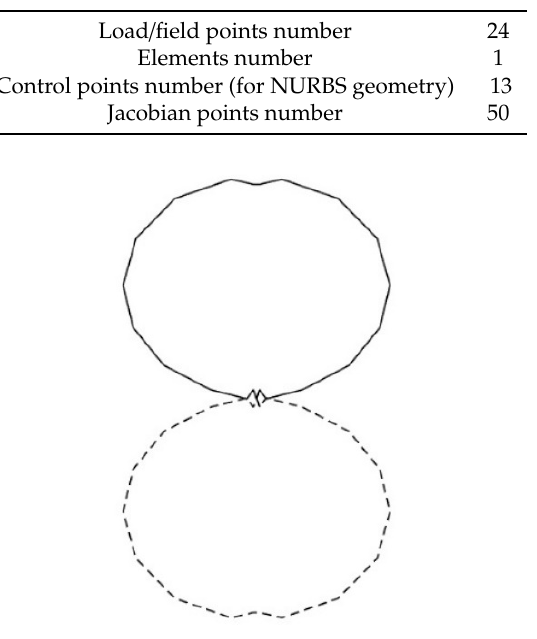
Table 6. Data to run the PSO algorithm. Table 7. Data to analyze the contact problem with the proposed method.